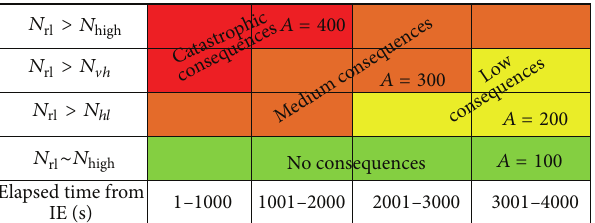
Figure 10: Matrix representation of the intensity coefficient 𝐴 .